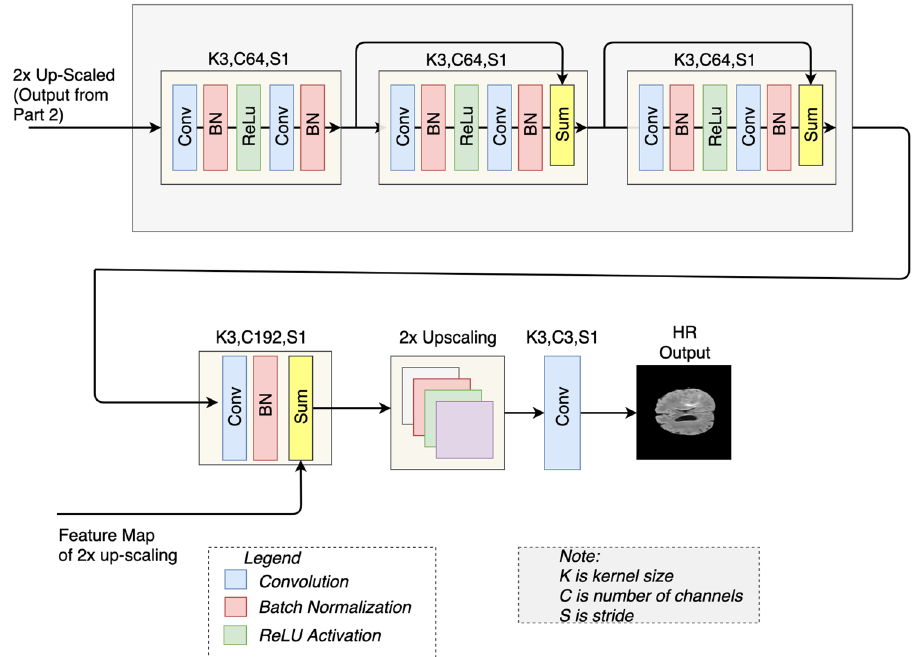
Figure 4. Mini-network: architecture for the mini-network showing the three residual blocks. The features map from Step 2 (see Fig. 3) are added with the output of the mini-network. K, C and S represents the Kernel size, number of Channel and Stride respectively. At the end of this step, we get 4x-upsacled high resolution (HR) image (Predicted HR image).